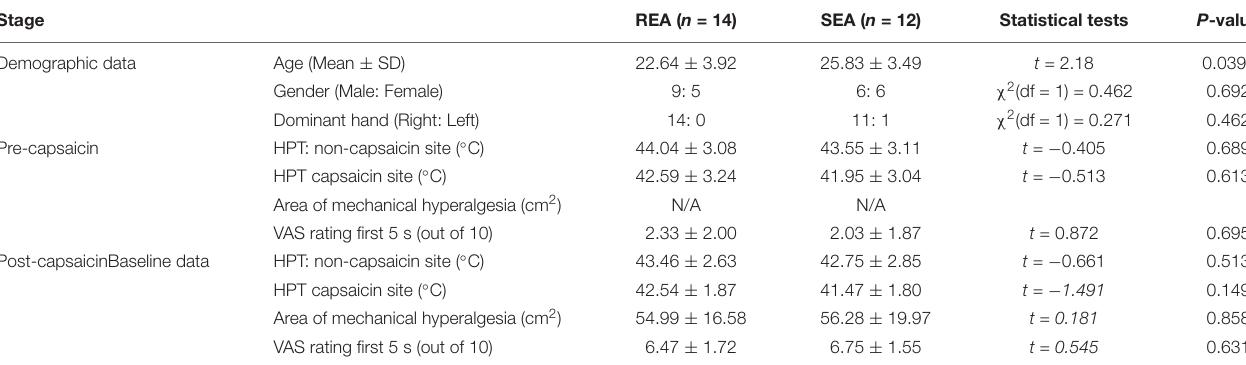
TABLE 1 | Demographic data and baseline data of heat and mechanism hyperalgesia in REA and SEA groups (Mean ± SD). Stage REA ( n = 14) SEA ( n = 12)